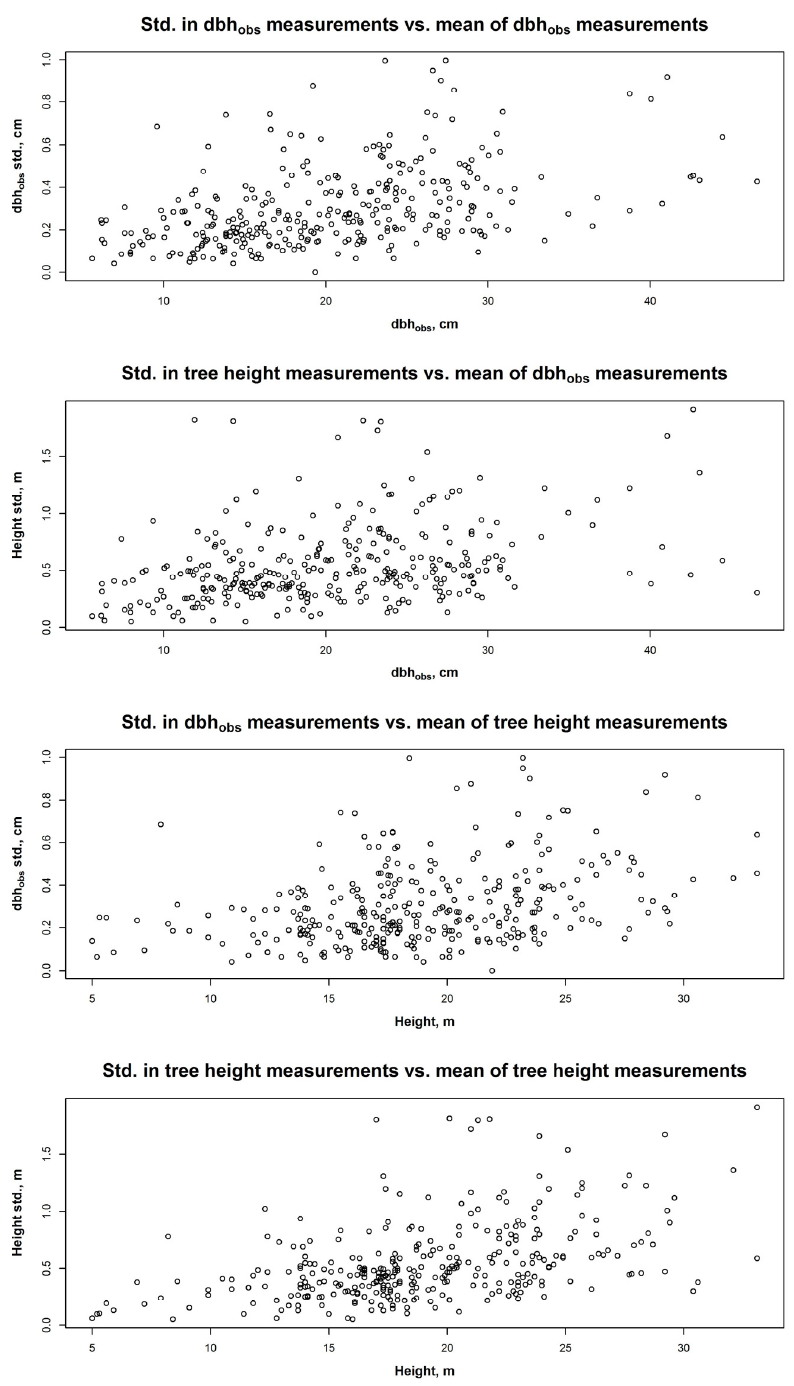
Figure 5. Standard deviation of tree dbh (diameter at the breast height) and tree h (height) measurements represented as the function of dbh and h of the sample trees.